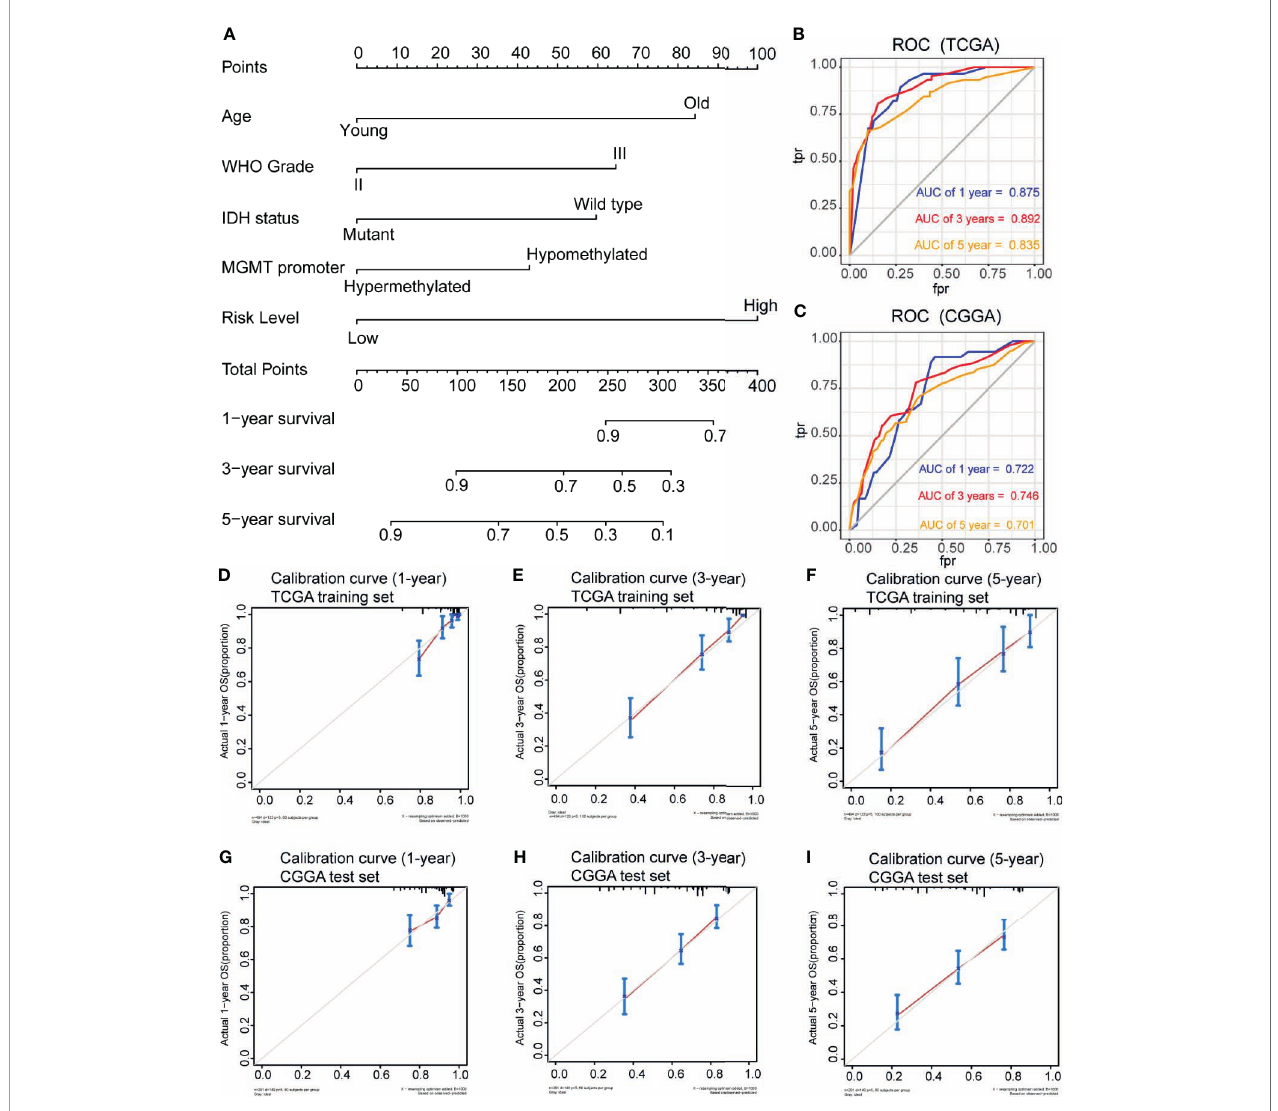
FIGURE 6 | Prognostic nomogram for the 1-, 3-, and 5-year OS times of LGG patients. (A) , Independent risk factors screened by multivariate Cox regression in the TCGA cohort were integrated into the nomogram model. ROC curves and AUC values of the nomogram for predicting 1-, 3-, and 5-year OS in the TCGA (B) and CGGA (C) cohorts. Calibration curves of the nomogram for predicting 1-, 3-, and 5-year OS in the TCGA (D – F) and CGGA (G – I)